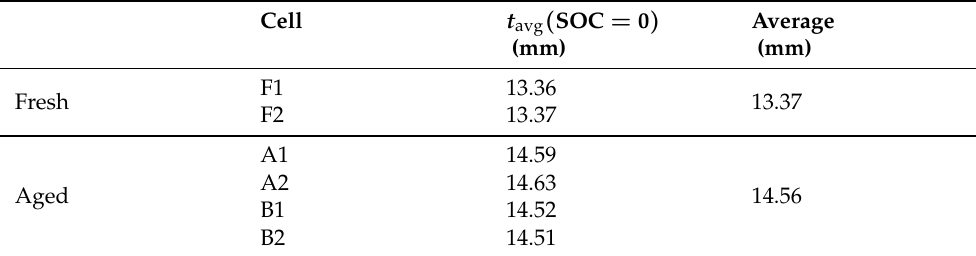
Table 3. Average thickness t avg ( SOC = 0 ) measured at 0%